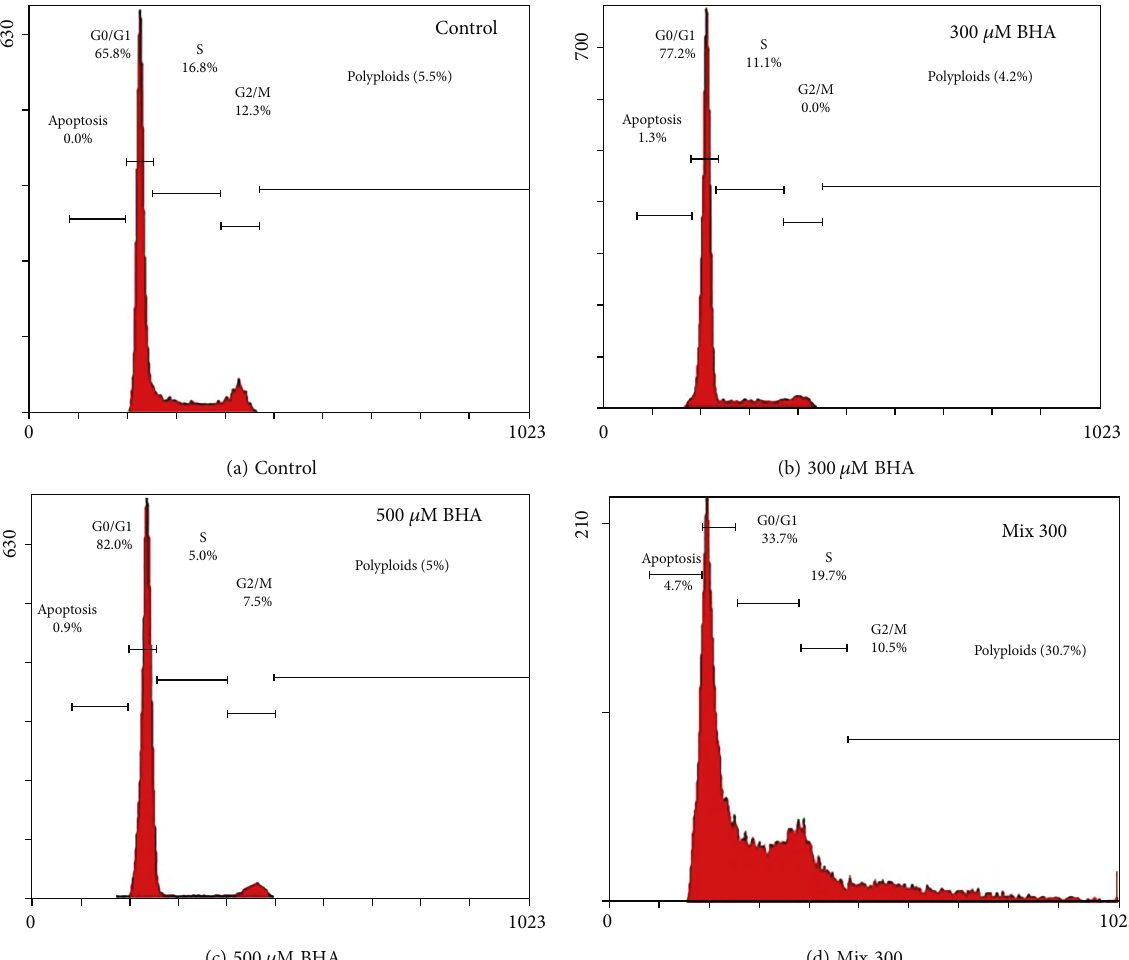
Figure 7: Representative histograms of the frequency of cells in the di ff erent phases of the cell cycle analysed after treatments with BHA and/or PPB for 24 hours ( n = 6 per